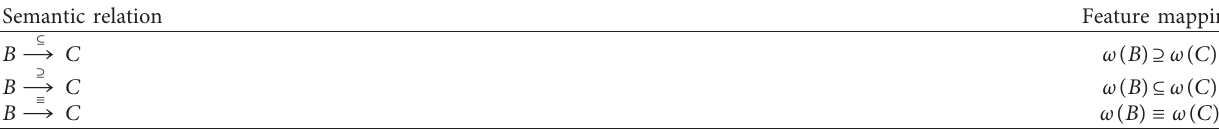
Table 1: Maps corresponding to the semantic relationships.